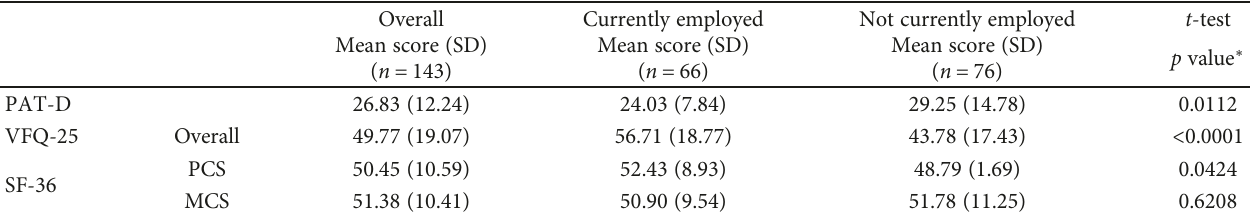
Table 5: Relationship between quality of life survey scores and current employment status. Overall